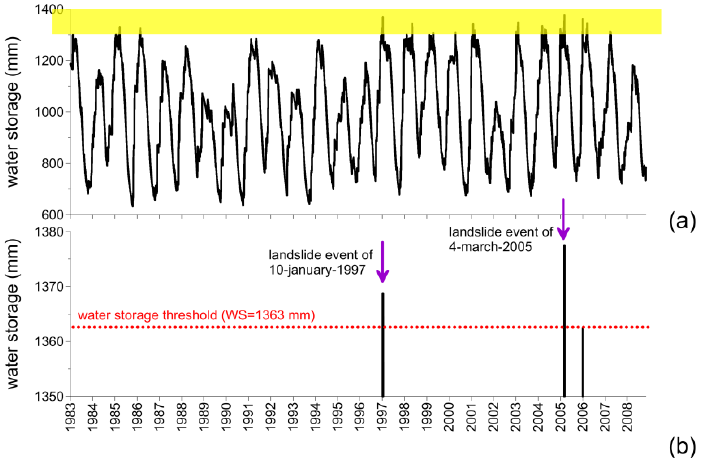
Figure 6. ( a ) evolution of bulk water storage simulated over 1983–2008 adopting observed data as weather input; the area highlighted in yellow identifies values higher than 1300 mm for a 2 m soil column; ( b ) zoom for water storage values higher than 1350